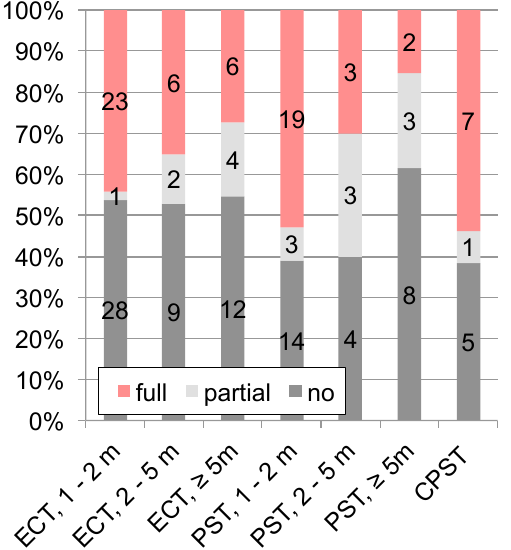
Figure 3. Propagation summary chart. Stacked columns are per- centages of tests that had no, partial, or full crack propagation. Each stacked column refers to a type of test (see Sect. 1) and beam length. Numbers inside stacked columns are counts of each propagation type.